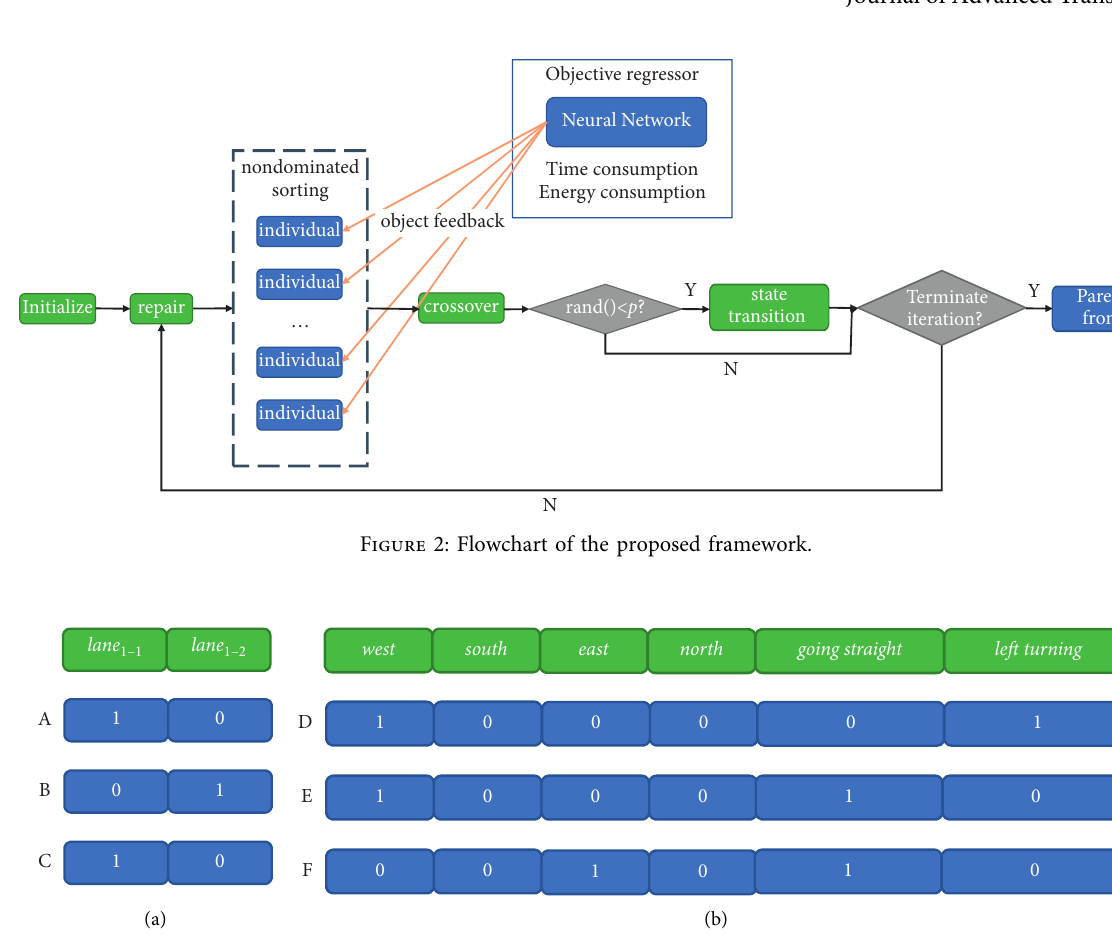
Figure 3: Encoding of lane of vehicles, which takes the state in Figure 1 as an example. (a) Example of Figure 1(a) and (b) example of Figure